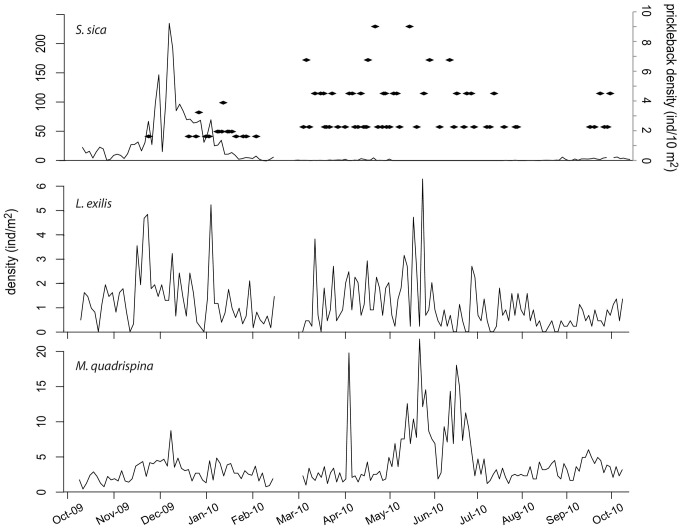
Time series of species densities between October 2009 and October 2010 in the camera field of view in Saanich Inlet.The shrimp Spirontocaris sica (black line) and the prickleback Plectobranchus evides (black dots) (upper); the flatfish Lyopsetta exilis (middle); and the squat lobster Munida quadrispina (lower). Note the variation in density scale among species.